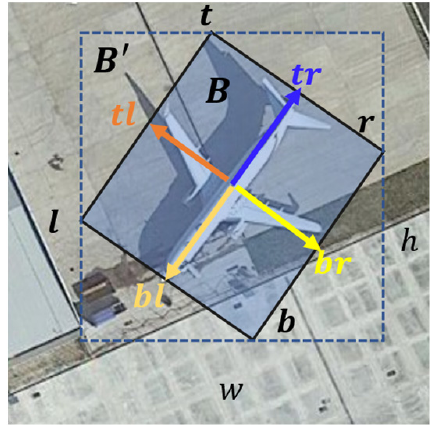
Figure 3. The definition of the Size parameter.